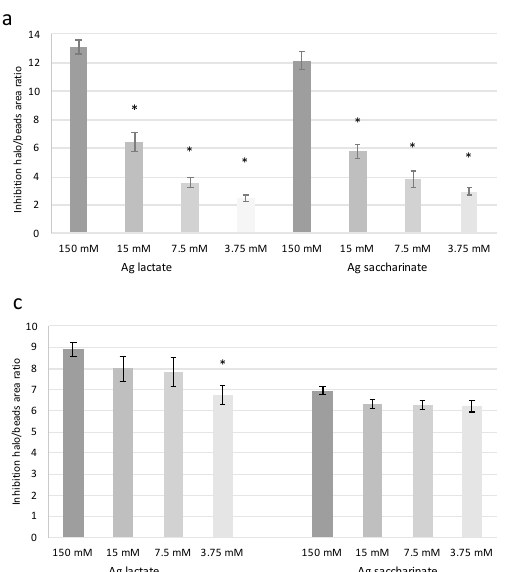
150 mM 15 mM 7.5 mM 3.75 mM